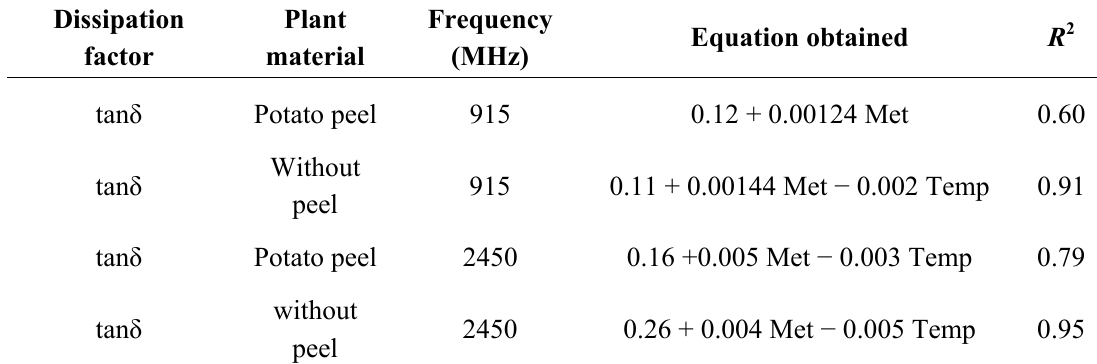
Table 3. Equation obtained defining the relationship of dissipation factor (tan δ ) with temperature and methanol fraction concentration at 2450 MHz and 915 MHz (Source: Adapted from